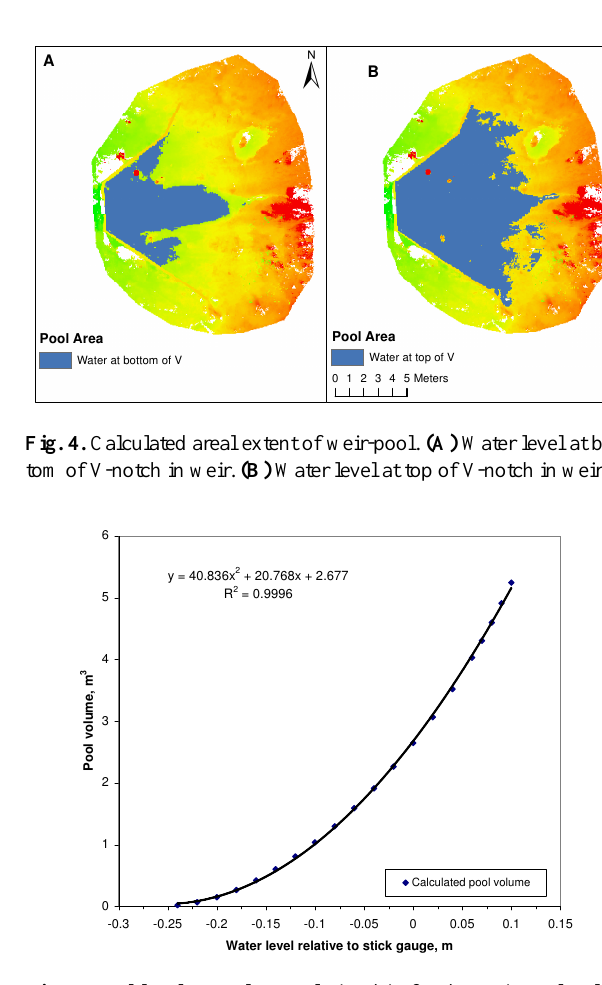
Fig. 5. Pool level vs. volume relationship for the weir pool at lev- els lower than exit flow, showing volumes calculated from the laser scan and the polynomial fit to the data. The bottom of the weir notch is at a height of 0.1m on the stick